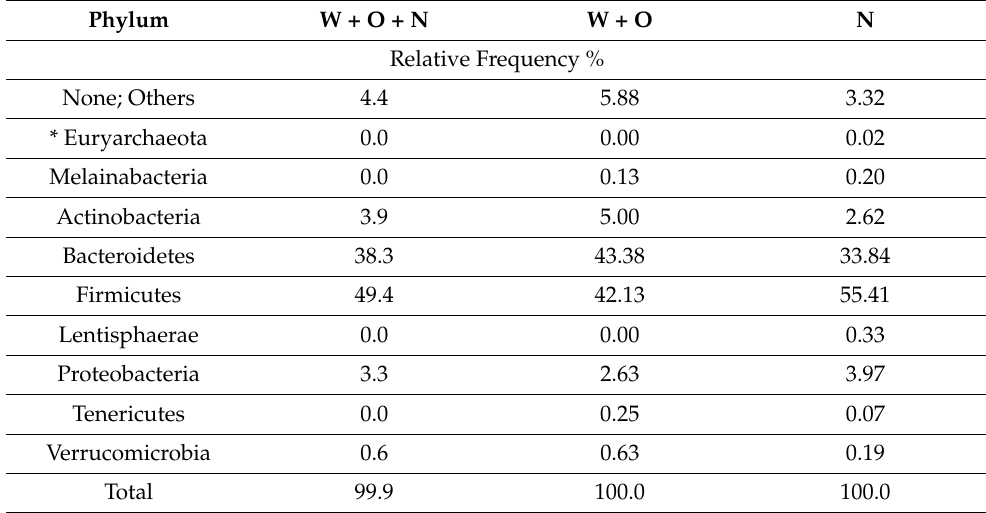
Table 1. Frequency of bacterial taxonomic groups in adolescents with different BMI status.